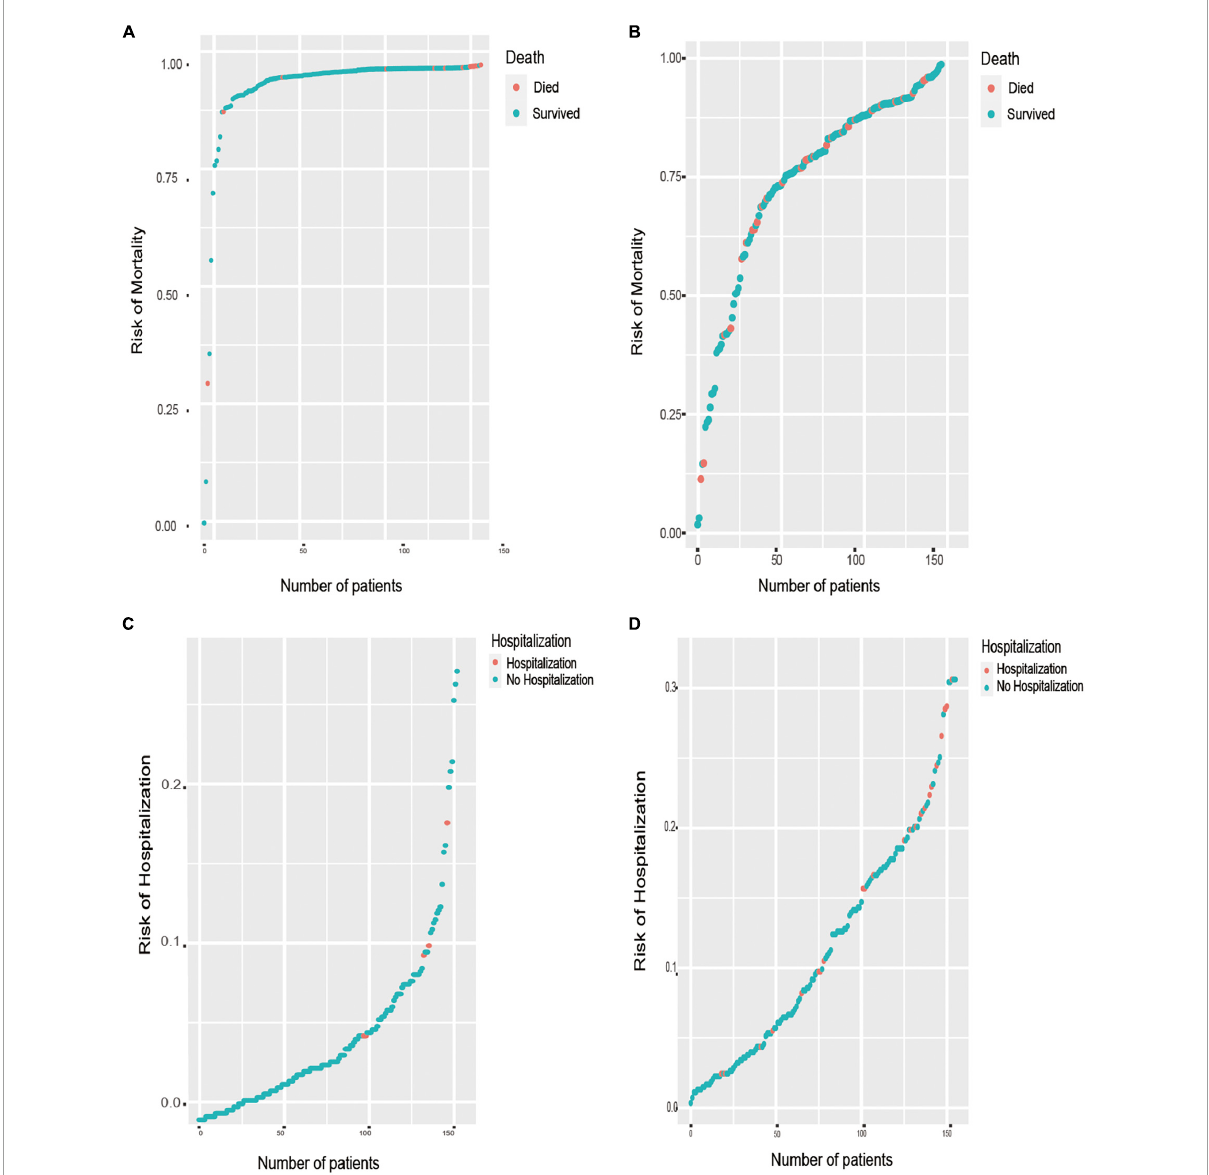
FIGURE5 Prediction distributions of patients with HFmrEF in the outcomes of all-cause mortality and HF hospitalization. (A) The distribution of all-cause mortality at the 1-year follow-ups, which there is a positive correlation between the number of patient deaths and the risk of mortality. (B) The distribution of all-cause mortality at the 6-year follow-ups. (C) The distribution of re-hospitalization at the 1-year follow-ups, which there is a positive correlation between the number of patients’ hospitalization and the risk of hospitalization. (D) The distribution of re-hospitalization at the 6-year